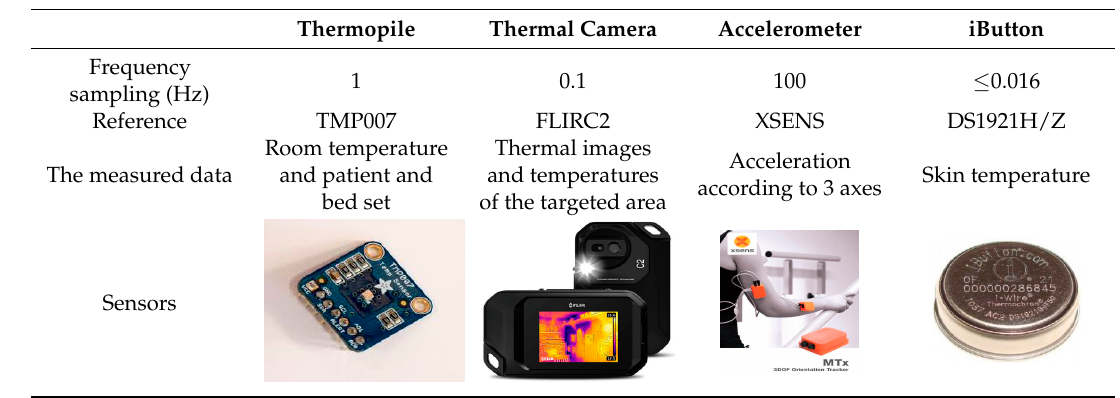
Table 1. Description of the sensors.